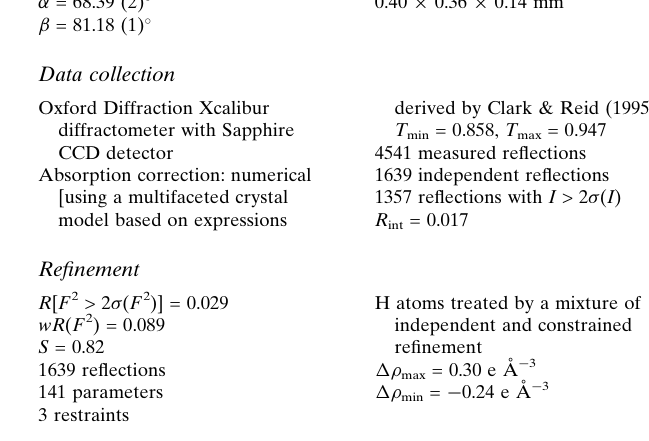
Oxford Diffraction Xcalibur diffractometer with Sapphire CCD detector Absorption correction: numerical [using a multifaceted crystal model based on expressions